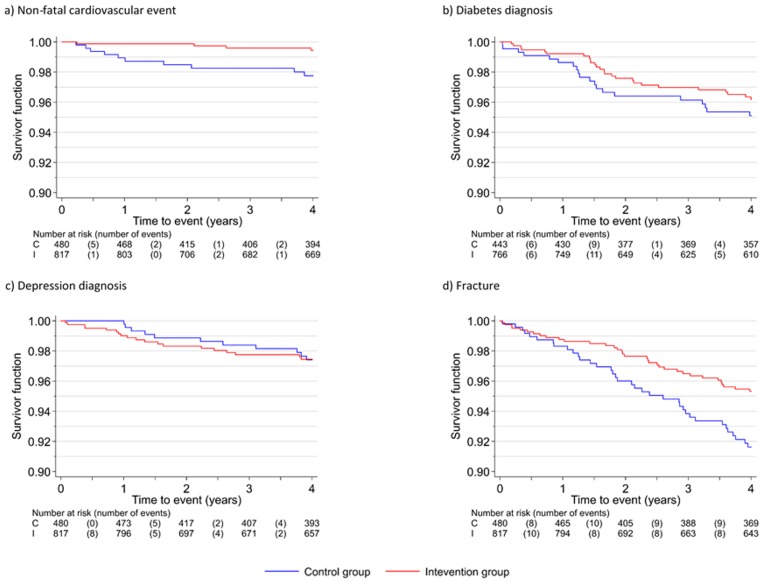
Kaplan-Meier curves for time to first event post-randomisation recorded in primary care records.